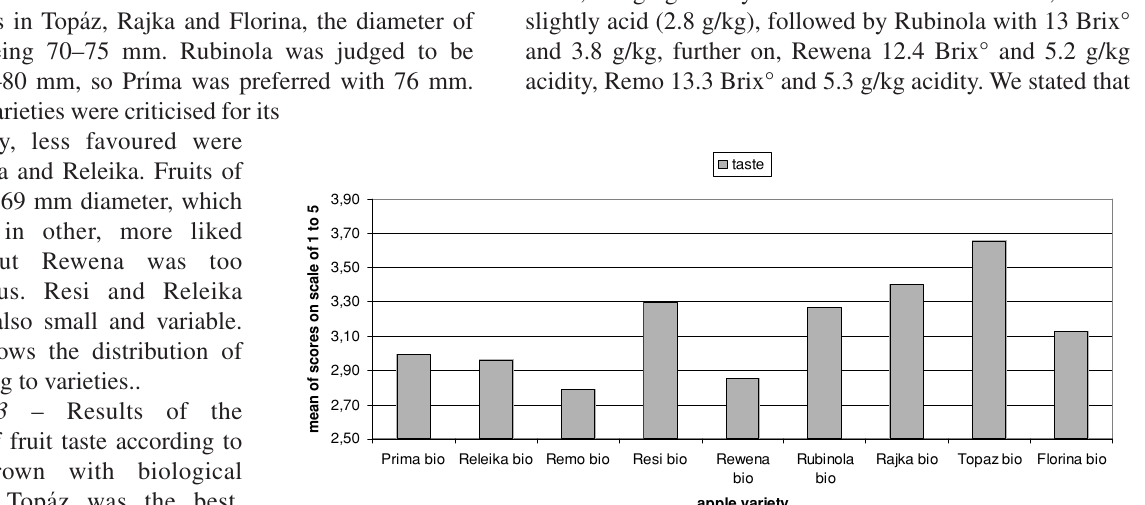
2,502,702,903,103,303,503,703,90 apple variety Figure 2: Size scores of fruits according to varieties were Rewena and Remo. The taste depended most on sugar and acid content of fruits. Sugar content was expressed by the Brix-degrees, acidity by the equivalent citric acid content. Topáz produced 12.4 Brix° and 4.9 g/kg acidity; Rajka 13.6